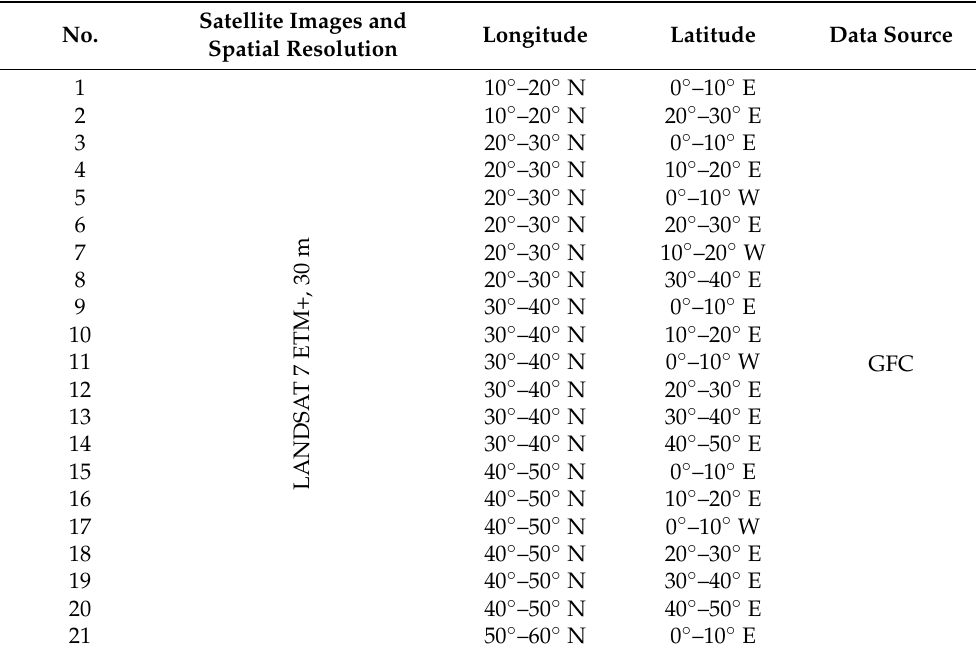
Table 1. Landsat-7 ETM+ geographical coordinates covering the study area (Data obtained from the Global Forest Change platform